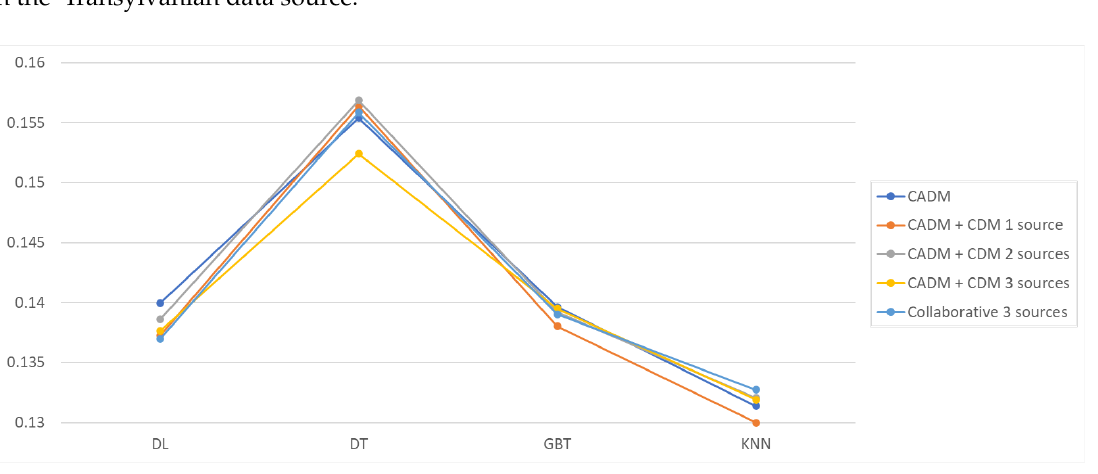
Figure 6. Relative Error (RE) representation of the overall results grouped by the tested algorithm: the algorithms ( X -axis) and the RE obtained values ( Y